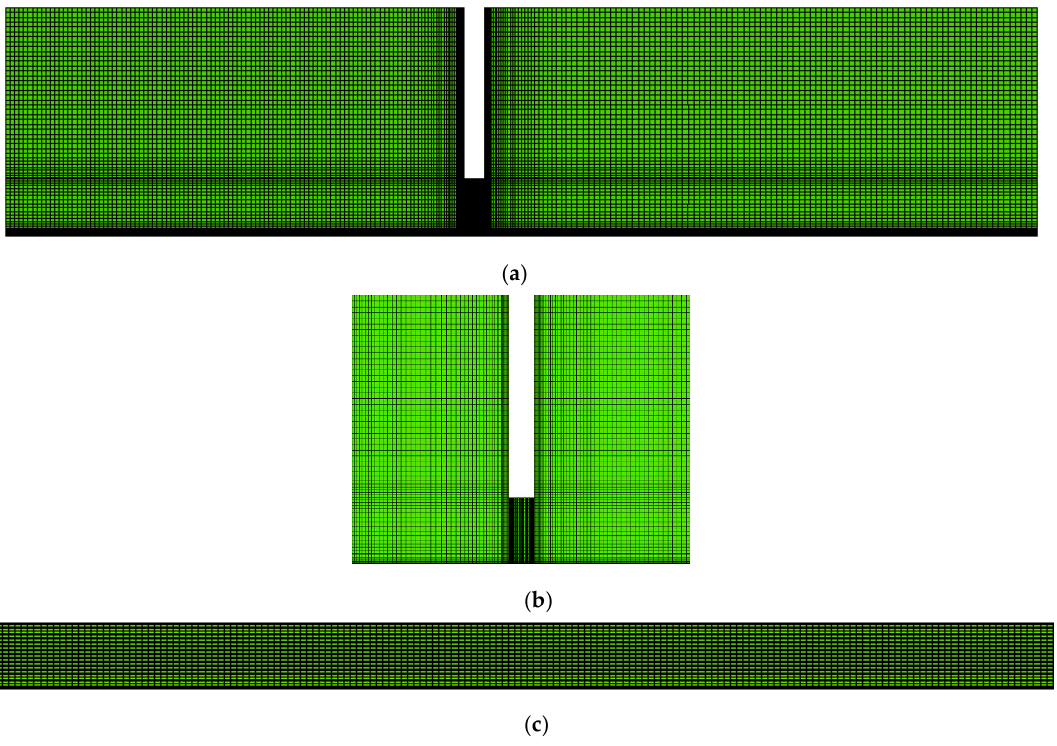
Figure 2. Middle section of the mesh of the impinging jet model: ( a ) oxz plane without jet; ( b ) oyz plane without jet; ( c ) enlarged jet rotating 90 degrees clockwise.